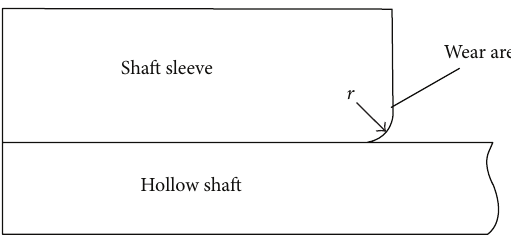
Figure 14: The wear schematic diagram of shaft sleeve.